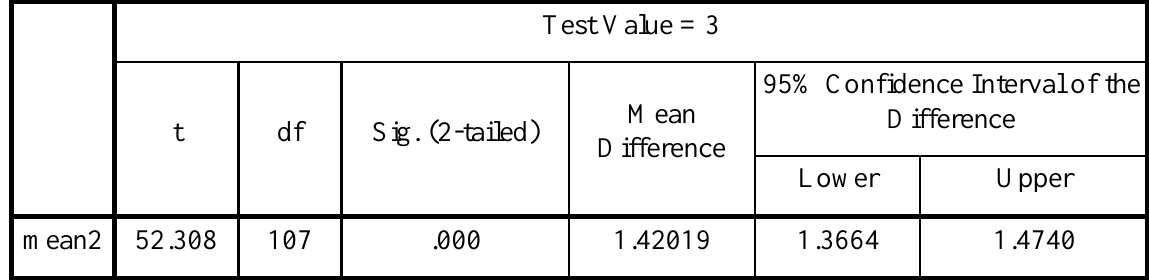
Figure 15. The results of t-test for the data of hypothesis